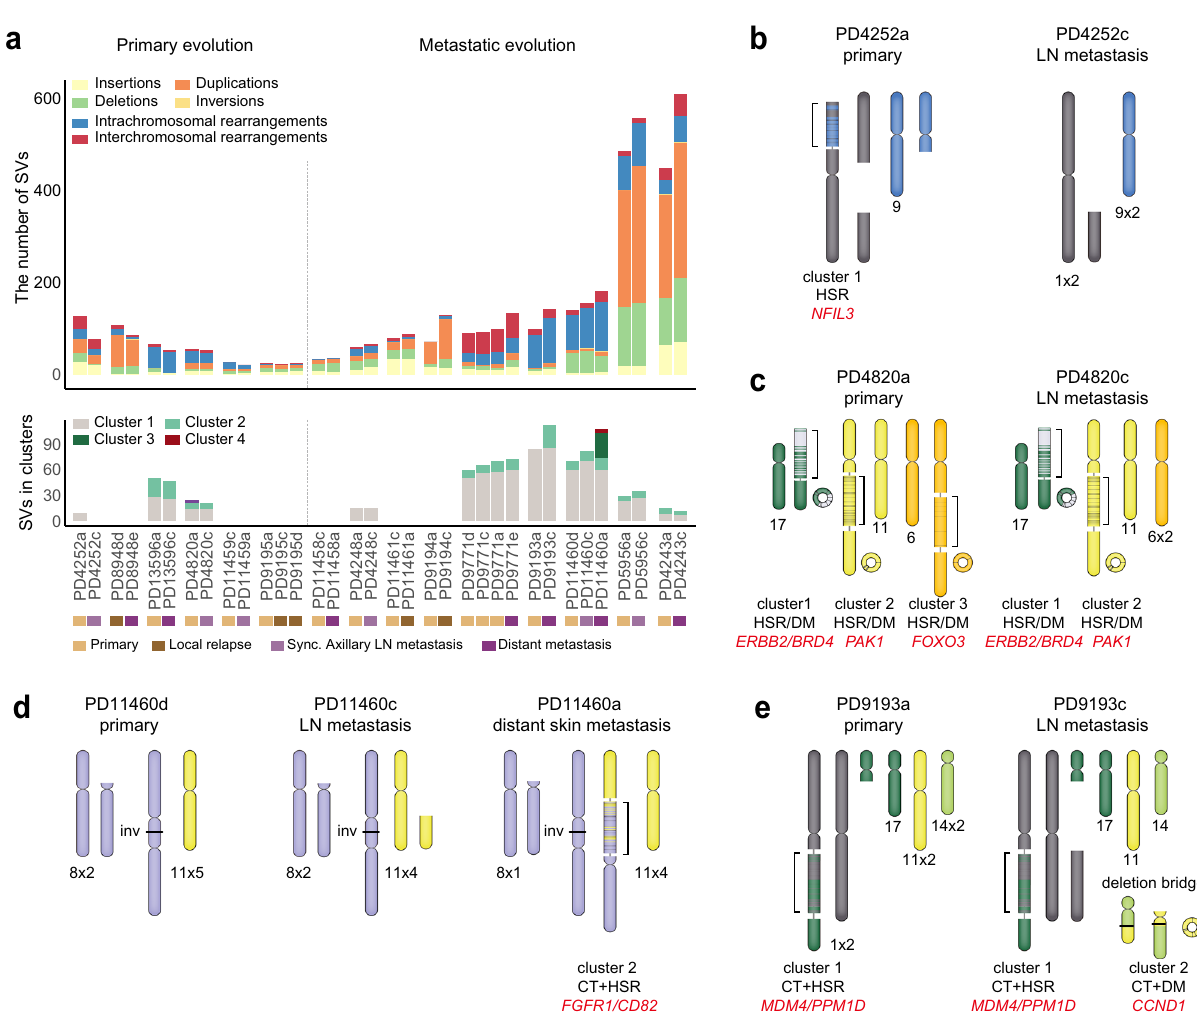
Fig. 5 The evolution of breast cancer genomes. a Bar plots of SVs and SV clusters discovered in metastatic and relapsed breast cancer from the European Genome – phenome Archive (EGA) data set 23 . The four cancer types studied included: primary tumour, local relapse, synchronous axillary LN metastasis and distant metastasis. The cancer types were sorted in the listed order, and the patients were classi fi ed as having primary or metastatic evolution depending on the accumulative patterns of SVs. b Patient PD4252 showed karyotypic evolution of chromosomes 1 and 9. c Patient PD4820 showed karyotypic evolution of chromosome 6. d Patient PD11460 showed karyotypic evolution of chromosomes 8 and 11. e Patient PD9193 showed karyotypic evolution of chromosomes 11 and 14. b – e The patient identi fi er of the EGA is shown at the top of each karyotype. Cancer-related genes are shown in red tumour (PD9193c) (Fig. 5e). A new DM (cluster 2) was generated ampli fi ed CCND1 (>30 copies). The remaining segments of